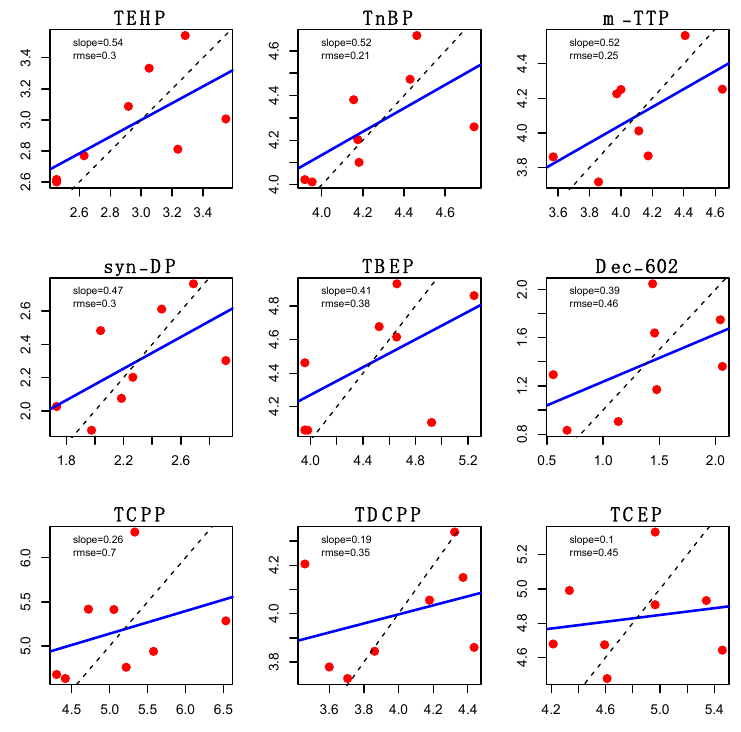
Figure 5. Linear regression plots comparing measured and estimated concentrations of the top nine performing OFRs identified by PLS regression when cities that did not induce cytotoxicity, and one outlier city were removed. The blue line indicates the regression between estimated and actual OFR concentrations values. The dashed line represents a perfect 1-to-1 prediction. Red dots represent the samples from each city.